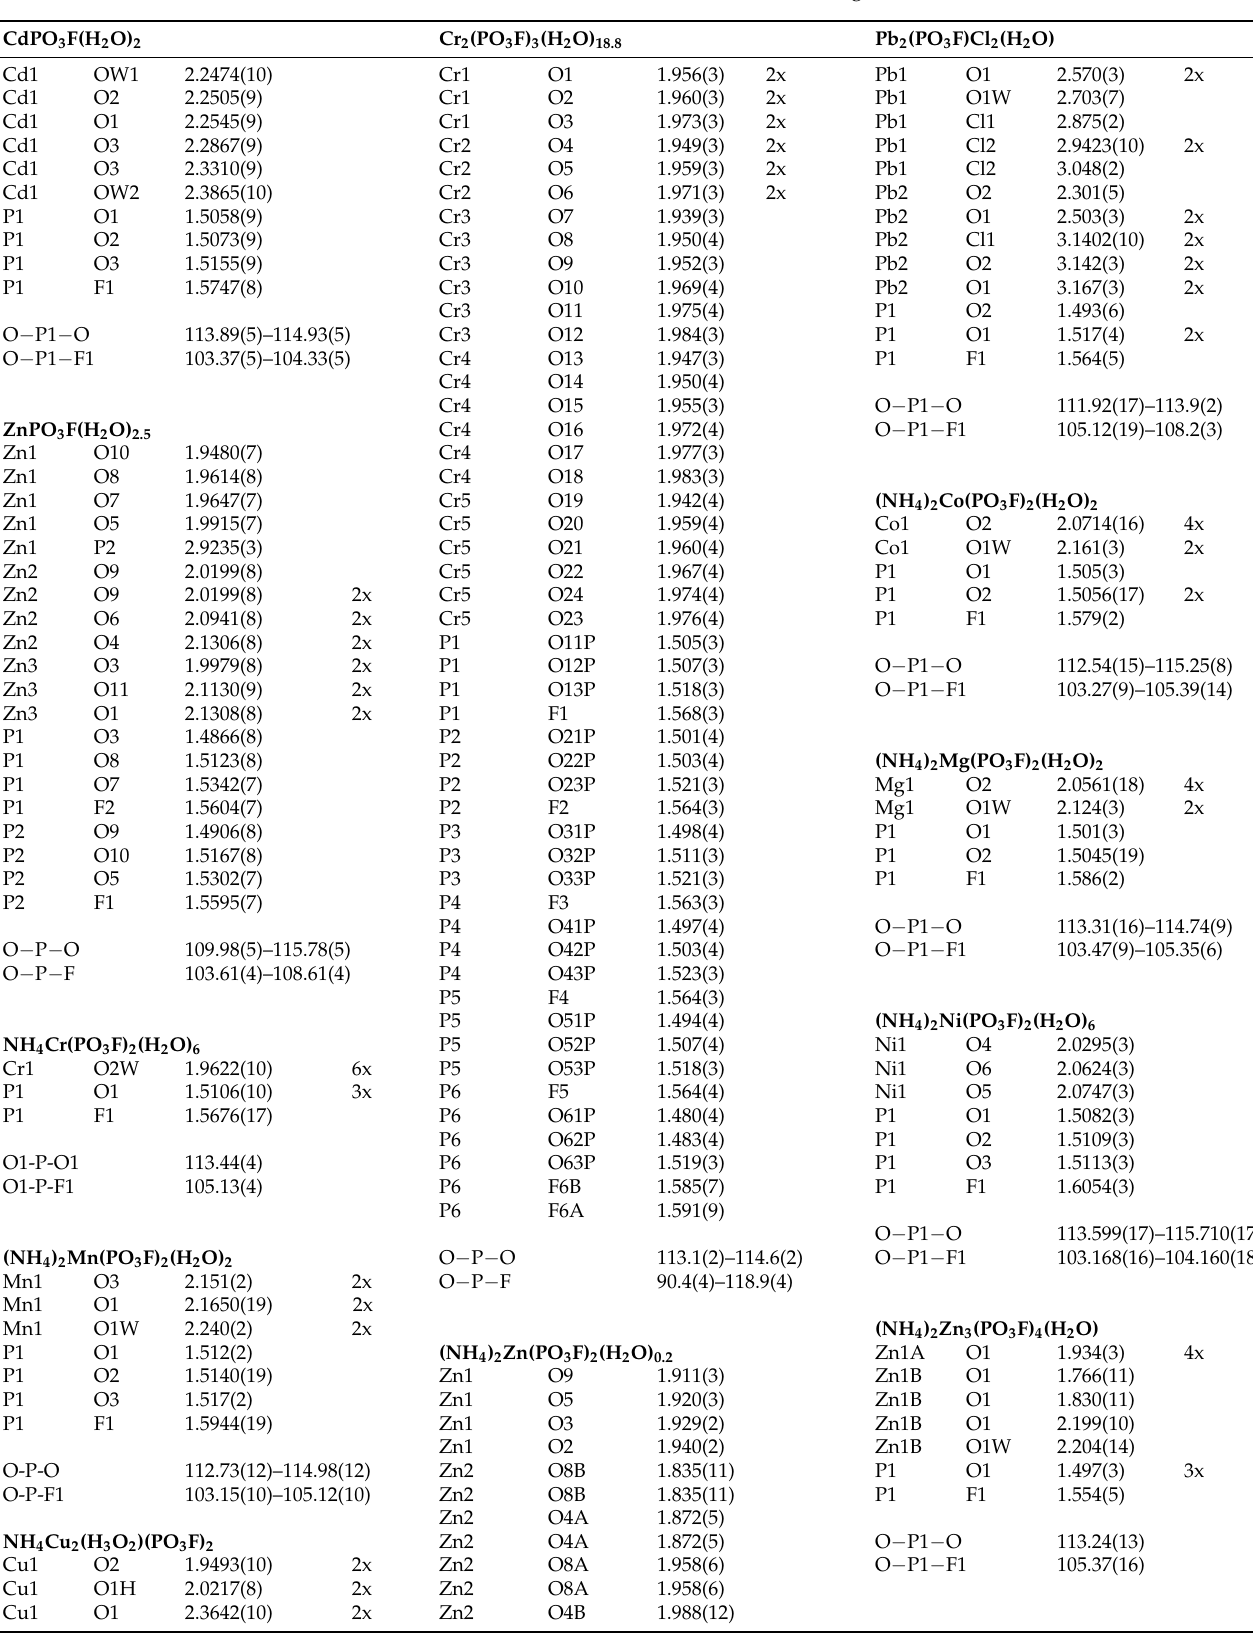
Table 2. Selected interatomic distances/Å and angles/ ◦